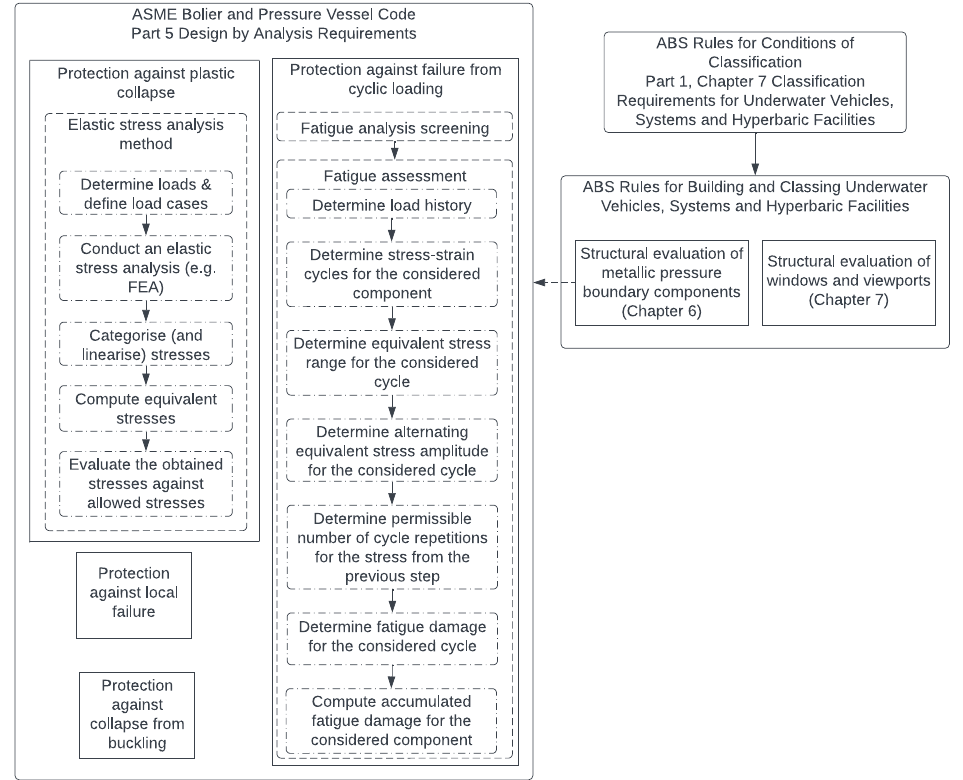
Figure 1. The standard and the design-by-analysis procedure.